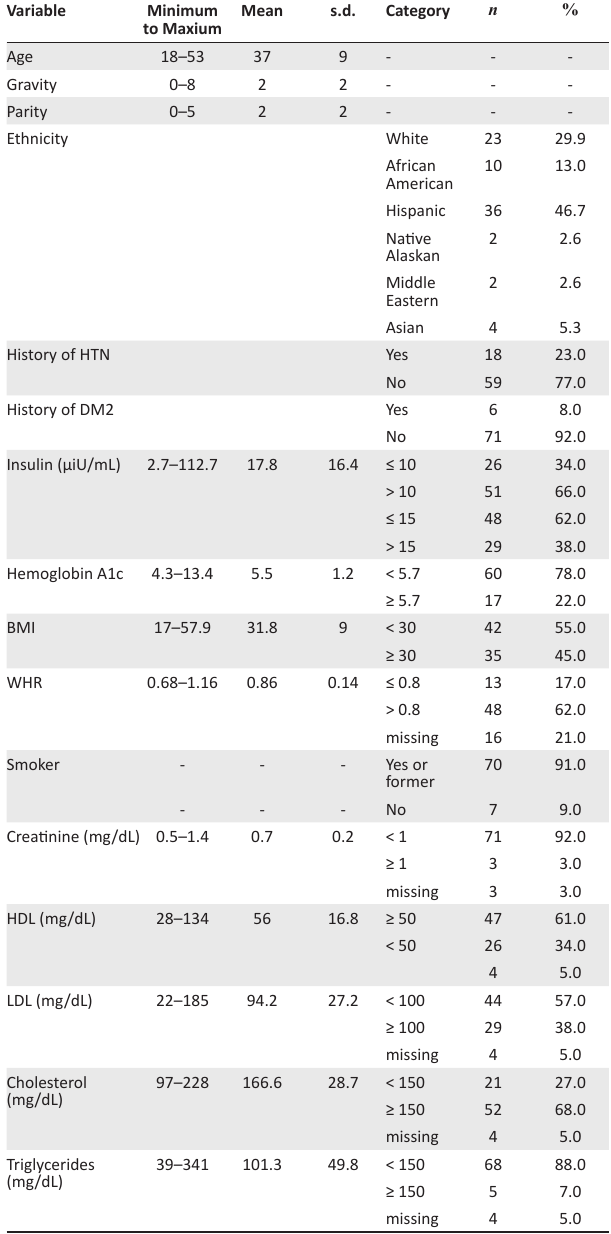
TABLE 1: Description of the study